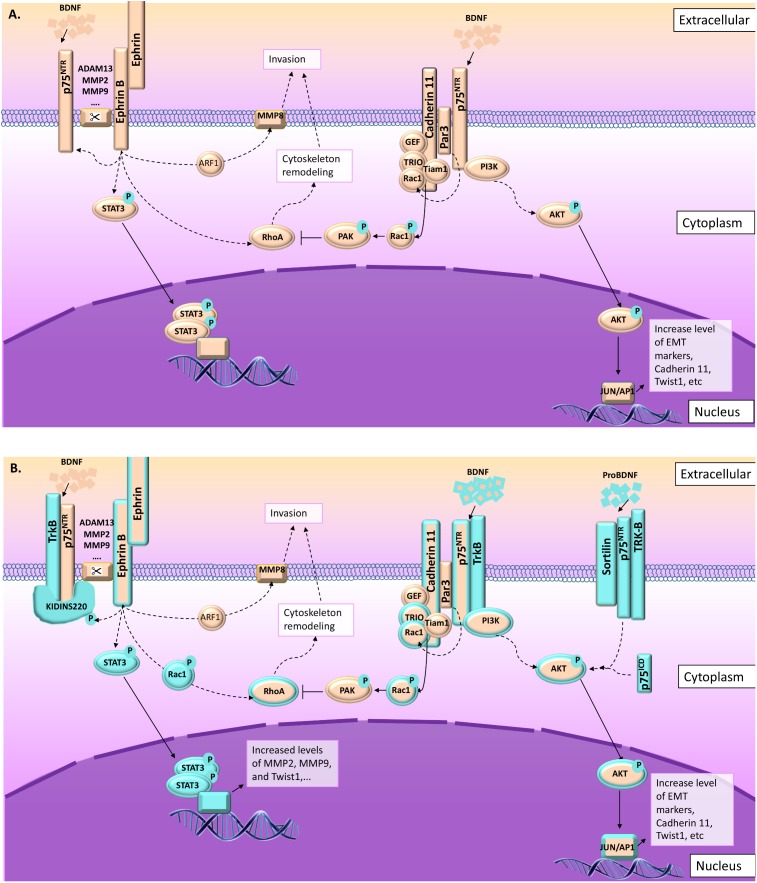
p75NTR and TrkB pathways leading to migration and invasion in normal and pathological conditions. As described in this figure, several signal pathways are preferentially activated in cell invasion and migration processes involving p75NTR upon NT activation. From the left to the right: (1) ephrin-B receptor phosphorylate Kidins220/ARMS leading to p75NTR/TrkB activation (Neubrand et al., 2012; Cai et al., 2017) and increasing their sensitivity to BDNF, leading to the activation of MAPkinase signaling pathways (Liao et al., 2011). Ephrin-B receptor activation is also linked to STAT3 and RhoA signaling leading to cytoskeleton remodeling (Marler et al., 2010; Neubrand et al., 2012). (2) In the absence of Kidins220/ARMS, p75NTR/TrkB could interact with other scaffold proteins like Par3 (Moore et al., 2013; Gomez et al., 2018). In this context, the BDNF activates p75NTR/TrkB leading to AKT pathway activation, but also to Par3 activation (Gomez et al., 2018). Activated Par3 activates Rac1, which modifies cadherin-11 interaction with catenins leading to cytoskeleton remodeling (Moore et al., 2013). (3) In some cases, p75NTR/TrkB also interact with sortilin leading to a high sensitivity to proBDNF. ProBDNF/p75NTR/TrkB also activate AKT pathway (De la Cruz-Morcillo et al., 2016). (A) Information collected from NCC migration and invasion during the development. (B) Information collected from cancer studies (highlighted in blue). Orange and blue borders = information related to both situations, NCC and cancer cells migration and invasion.